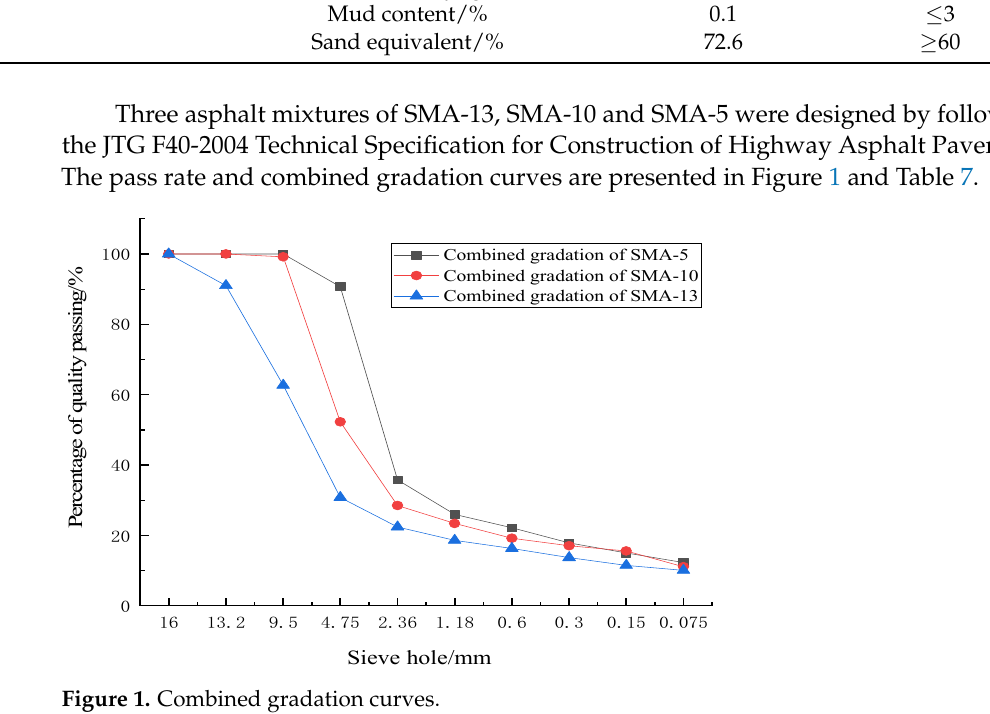
Table 6. Properties of aggregate.